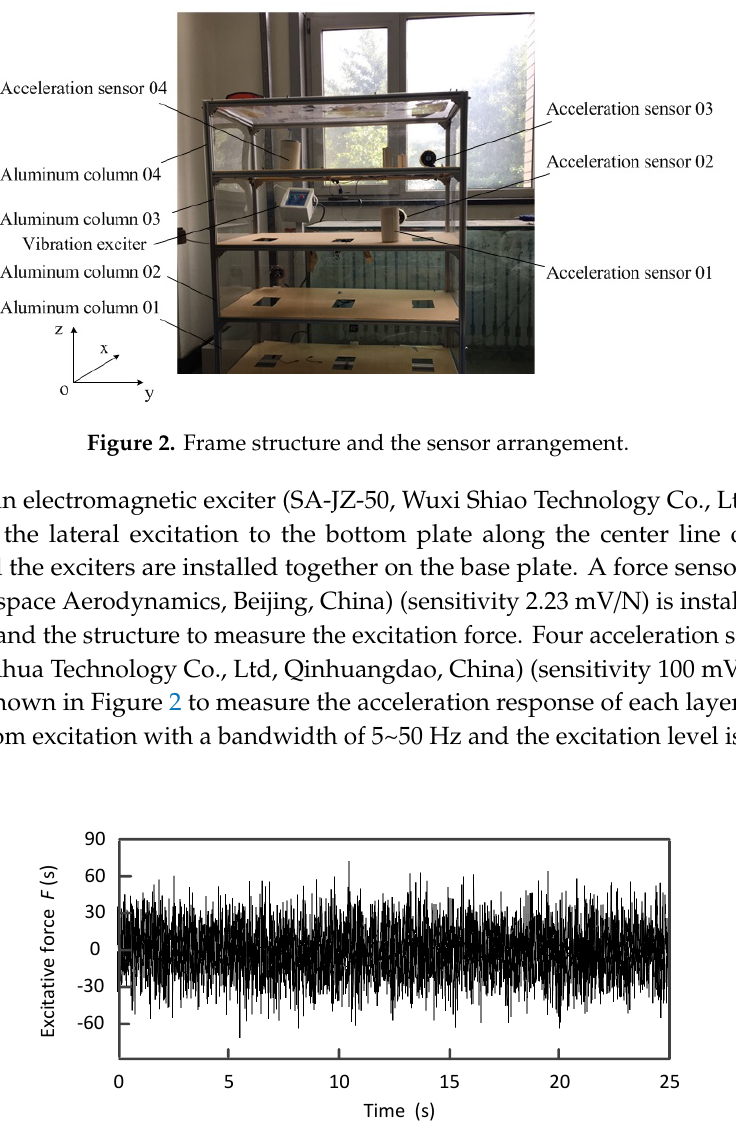
Table 1. Physical experiment condition of the frame structure.